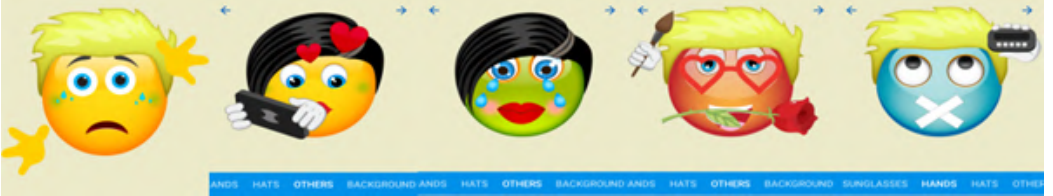
Figure 89: Presentation of paper